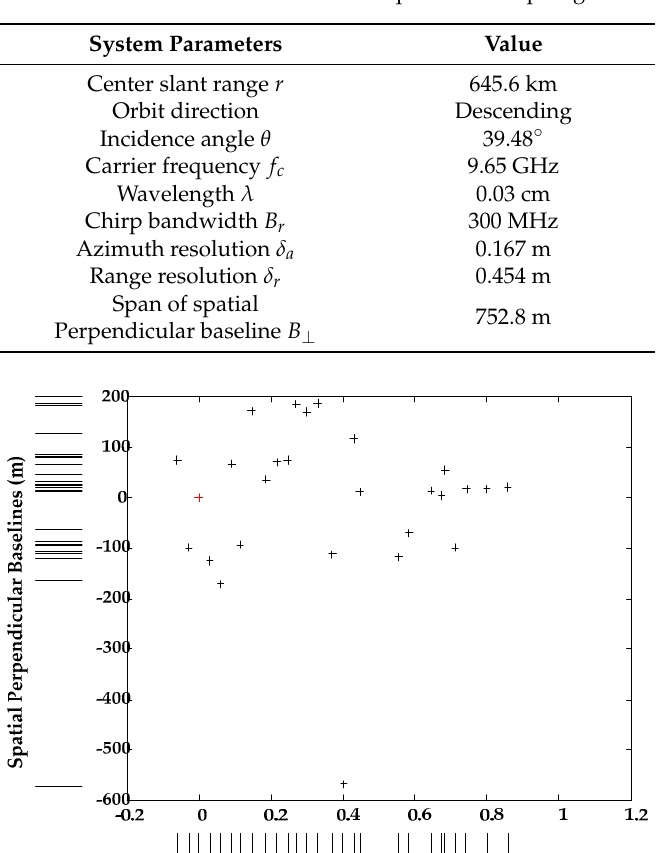
Table 1. Parameters of the TerraSAR-X acquisitions in spotlight mode.